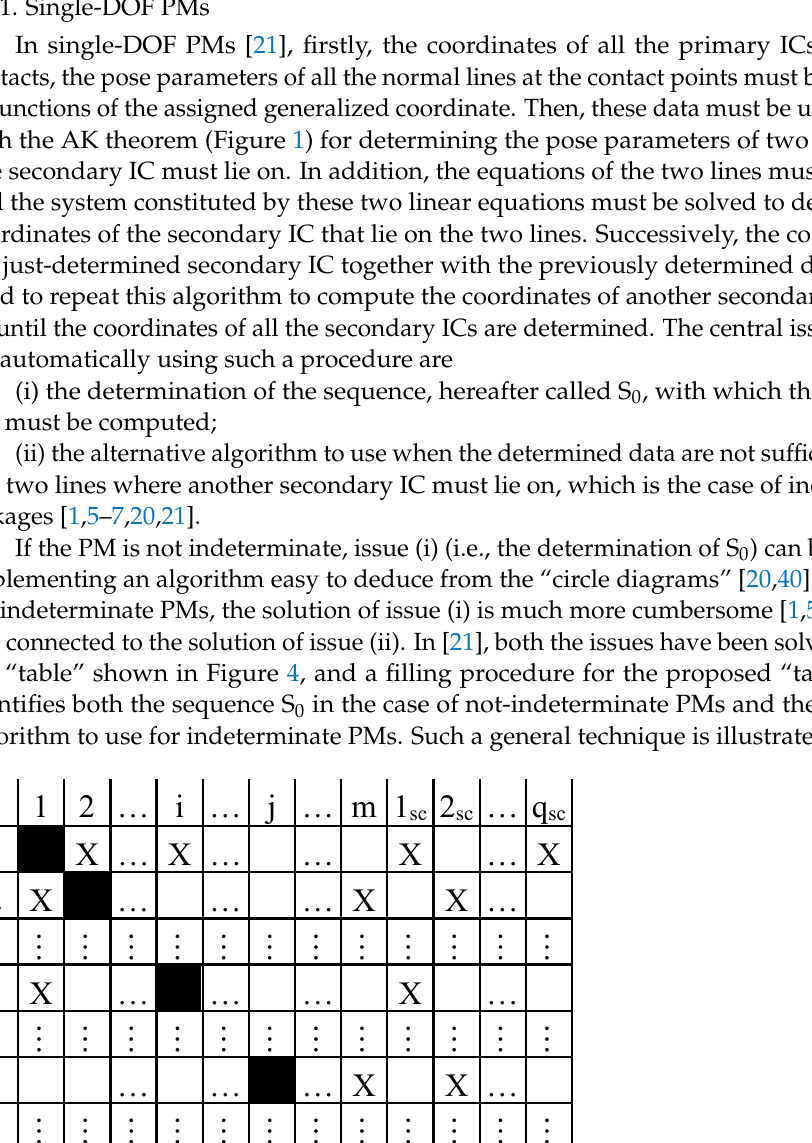
Figure 4. Table proposed in [21] to determine all the secondary ICs of a single-DOF PM with m links and q C s -contacts. The first row (column) just contains the column (row) index and it is just a heading row (column). The table to use (Figure 4) for a single-DOF PM with m links and q C s -contacts has m rows, which one-to-one correspond to the m links, and (m + q) columns with the first m columns corresponding one-to-one to the m links and the last q columns corresponding one-to-one to the q C s -contacts. In the first m columns, the cells with the row index equal to the column index are black; whereas, all the remaining cells are empty at the beginning of the filling procedure. In these columns, the cell indices identify the IC with the same lower-right indices, that is, the cell (i, j) corresponds to the IC C ij . Since C ij and C ji are the same IC, there are two cells for each IC, which are symmetrically disposed with respect to the diagonal black cells. In the last q columns, only the two cells whose row indices correspond to one or the other of the two links joined by the C s -contact the column refers to are filled with the symbol “X” and the remaining cells are left empty. In these other columns the two filled cells indicate that the pose parameters of a line, which the IC